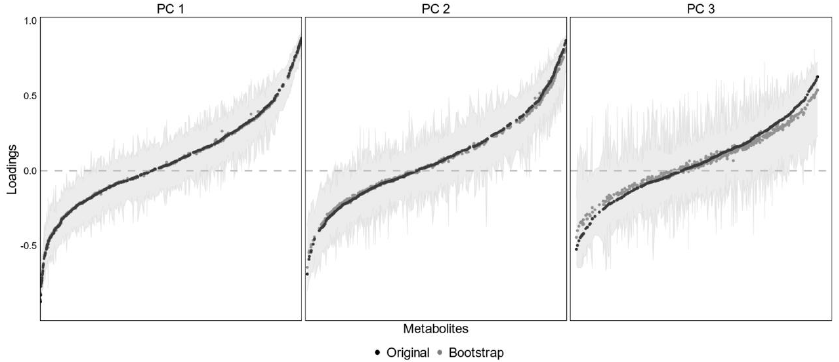
Figure 1. PCA loadings of bootstrap samples.